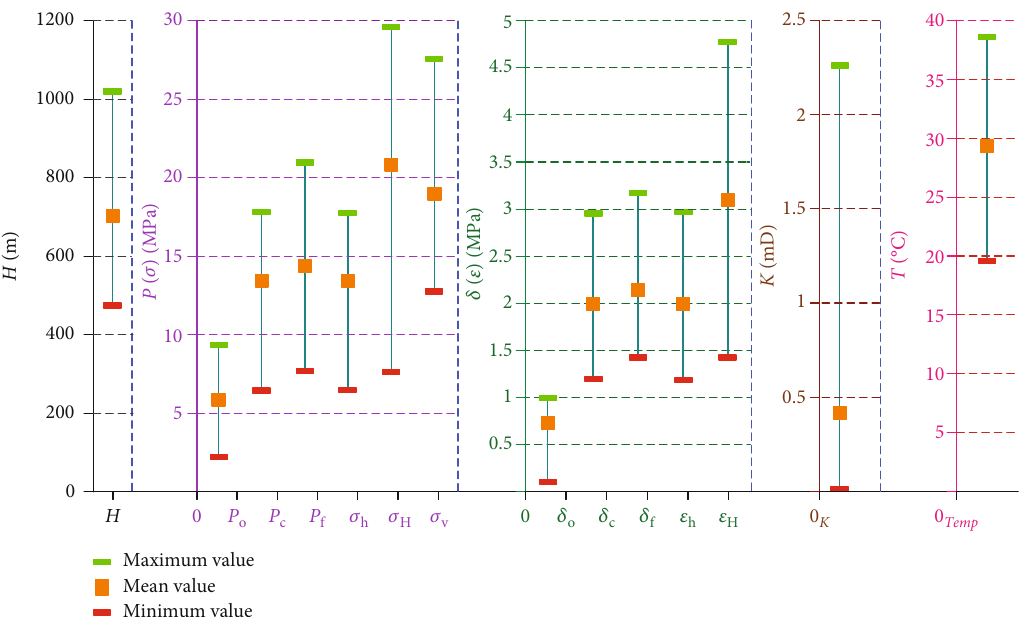
Figure 4: Stock chart of injection/fallo ff well test and in situ stress measurement parameters in Liulin area. H : represents the burial depth; P represents the initial reservoir pressure; P c : represents closure pressure; P f : represents fracture pressure; σ h : represents the minimum horizontal principal stress; σ H : represents the maximum horizontal principal stress; σ v : represents vertical stress; δ o : represents the initial reservoir pressure gradient; δ c : represents closure pressure gradient; δ f : represents fracture pressure gradient; ε h : represents the minimum horizontal principal stress gradient; ε H : represents the maximum horizontal principal stress gradient; K : represents the permeability; Temp: represents the reservoir